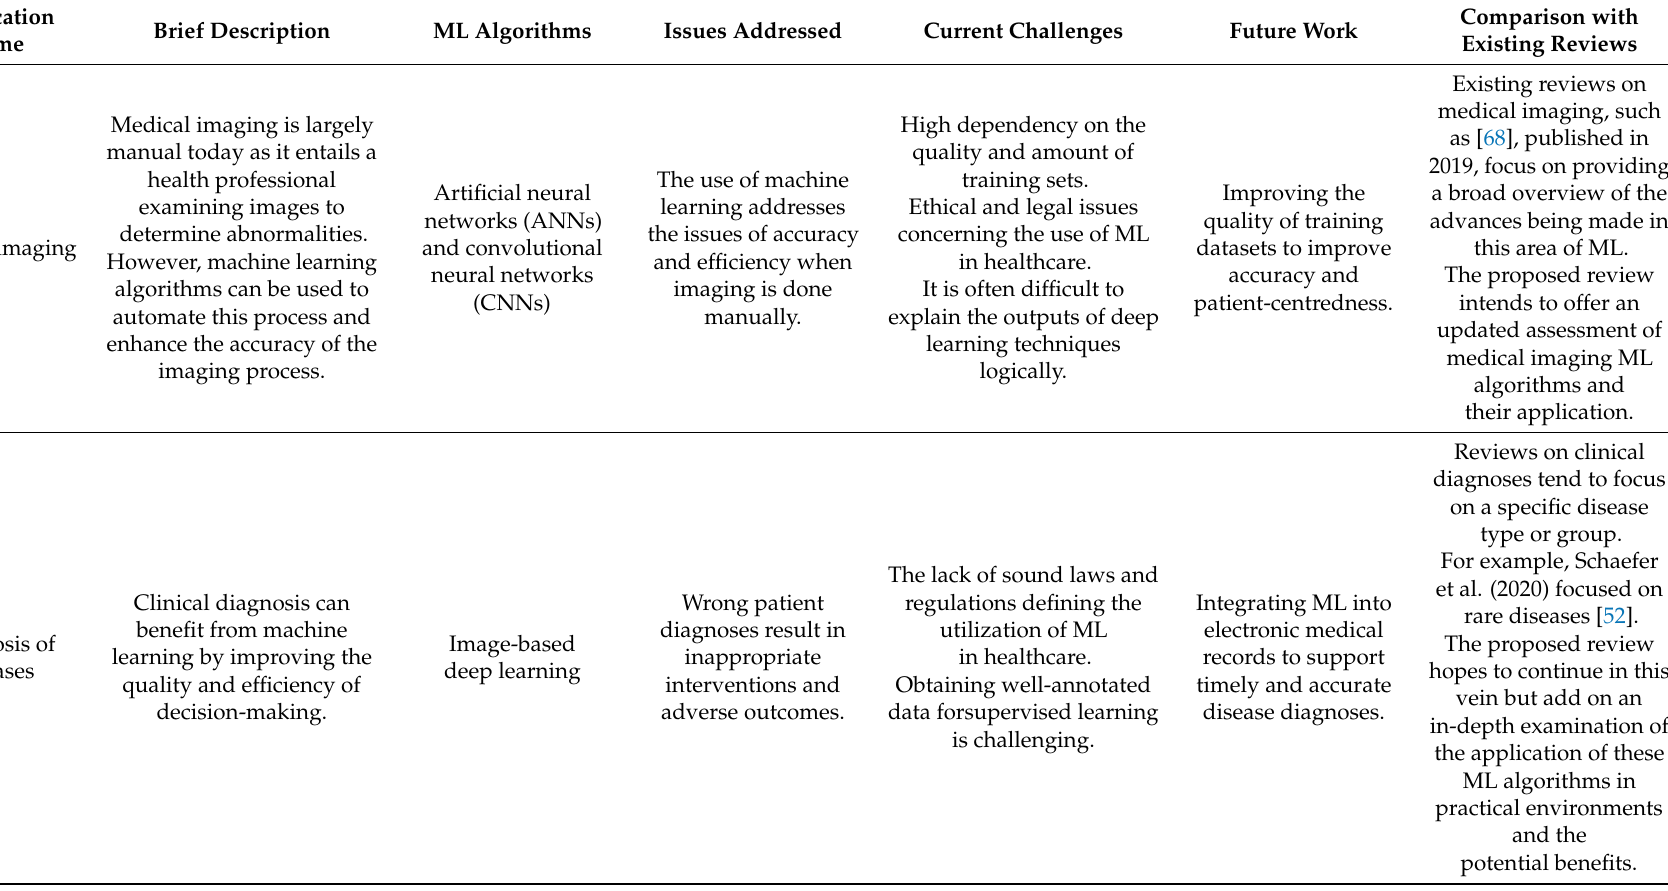
Table 4. Summary of the reviewed